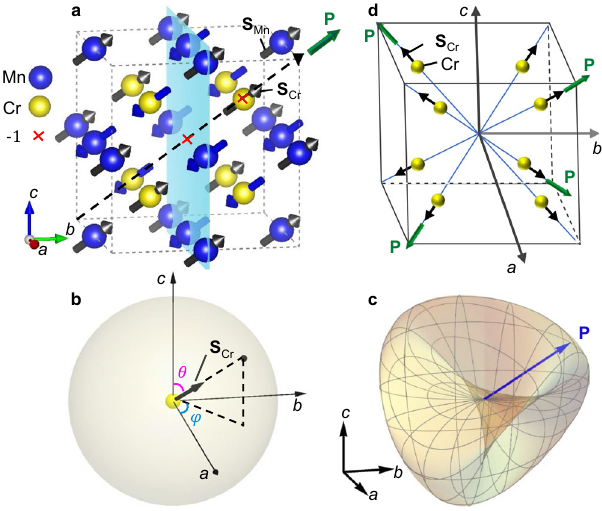
Fig. 3 Crystal, magnetic, and ferroelectric structures in A Mn 3 Cr 4 O 12 . a Crystal and spin con fi gurations where Cr and Mn atoms are presented in yellow and blue, respectively, and O atoms are omitted for clarity. The lattice symmetries of A Mn 3 Cr 4 O 12 : two space inversions (cid:1) 1 located at the center and at the Cr atom, one of the mirror planes (see the light-blue plane), and one of the three-fold rotation axes (see the dash line) are indicated. All spins composed of Mn and Cr magnetic sublattices are parallel or antiparallel to the [111] direction. Antiferromagnetic sublattices of Cr and Mn are denoted by Néel vectors S Cr and S Mn , respectively, and the induced polarization P is shown by the arrow in green. b Orientation of S Cr is represented in spherical coordinates ( μ Cr , θ , φ ). c Complete set of allowed spin-induced P vectors in three dimensions is a Roman surface when the magnetic structure shown in a coherently rotates on a sphere in b . d Distribution of P vectors along four of the eight diagonal directions. The yellow sphere and the black arrow denote the Cr atom and its spin moment. S Mn is always parallel to S Cr, and it is not shown for clarity. Thus, AFM con fi guration composed of Mn and Cr sublattices is indicated by S Cr . The black cube represents the crystal unit